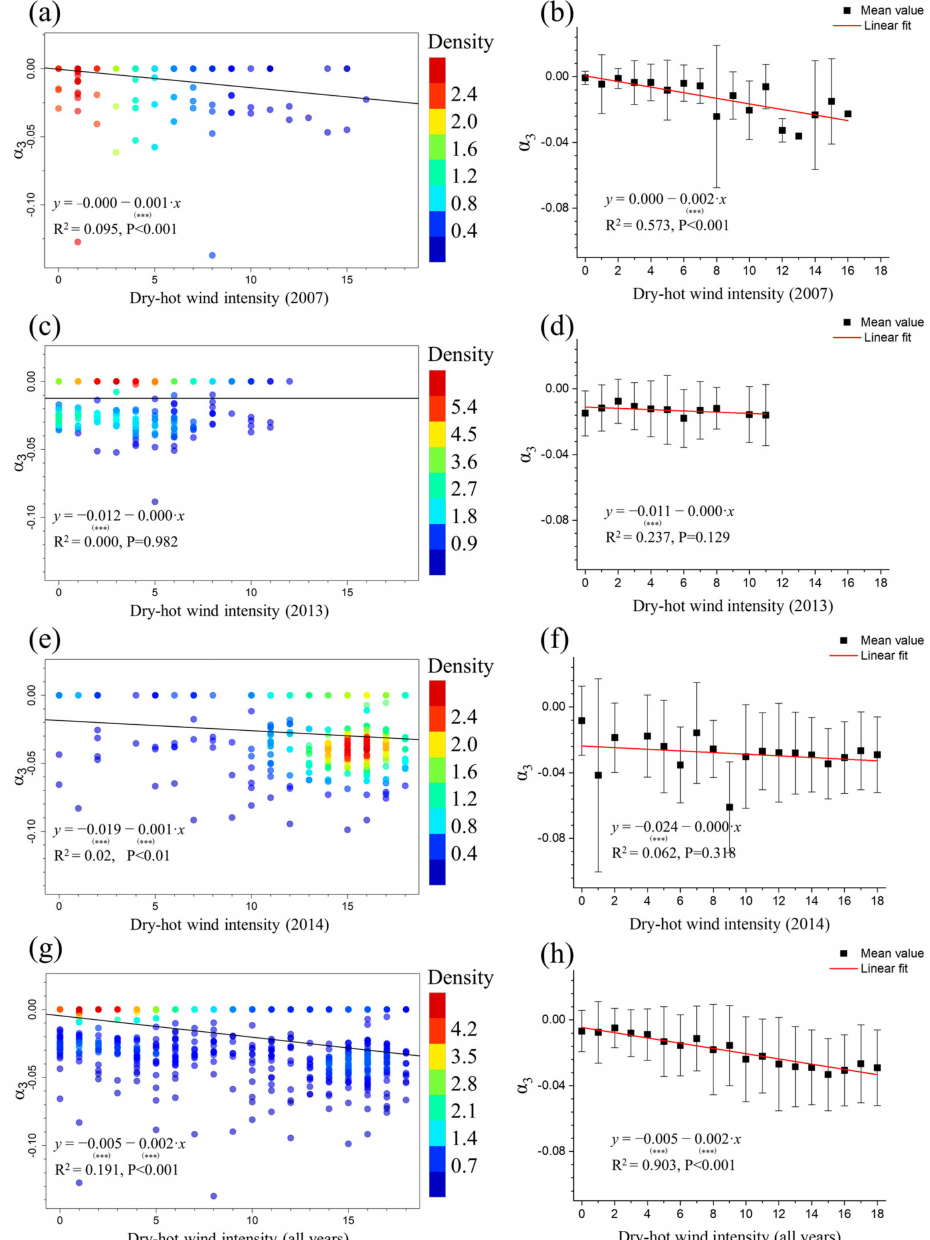
Figure 7. The comparison between the damage to winter wheat estimated by the DID-based method and the meteorological intensity of dry-hot wind hazards ( a , b ): 2007, ( c , d ): 2013, ( e , f ): 2014, ( g , h ): all three years; the colors in subplots ( a , c , e ), and ( g ) represent data point density estimated by kde2d function in R. They are related to the number of days with the same dry-hot wind intensity and similar α 3